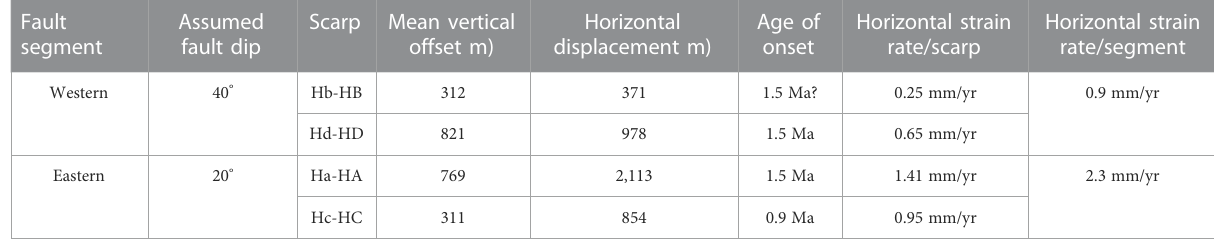
TABLE 3 Hypothetical horizontal strain rates across the two segments of the Boumerdès margin using assumed heaves on the four main scarps and ages of growth strata in perched basins PS1 and PS2. Age of onset for Scarp b is unknown and has been assumed as equivalent to the one of Scarp d. See text for